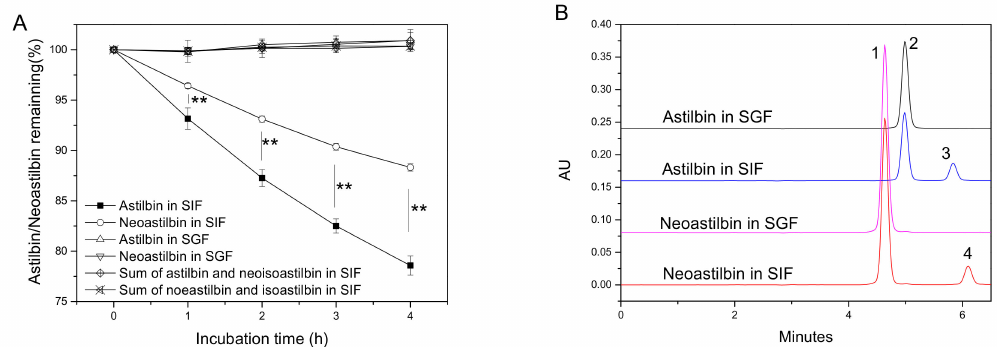
Figure 2. ( A ) Stability of astilbin and neoastilbin in SGF and SIF at 37 ◦ C (n = 3). ** means very significant di ff erence ( p < 0.01) between remaining astilbin and neoastilbin under the same incubation time in SIF. ( B ) The chromatograms of neoastilbin and astilbin after incubation in SIF and SGF for 4 h at 37 ◦ C, respectively. Peaks: 1, neoastilbin; 2, astilbin; 3, neoisoastilbin; 4,